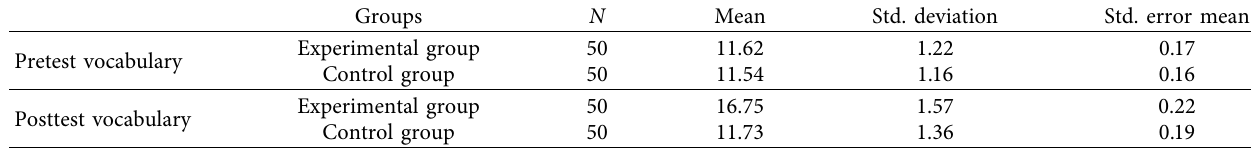
Table 1: Results of descriptive statistics for the pretest vocabulary and posttest vocabulary. Groups